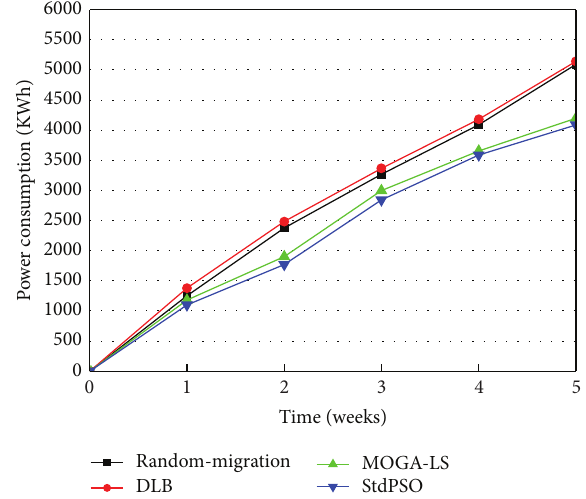
Figure 6: Comparison of random-migration, DLB, StdPSO, and MOGA-LS in power consumption.